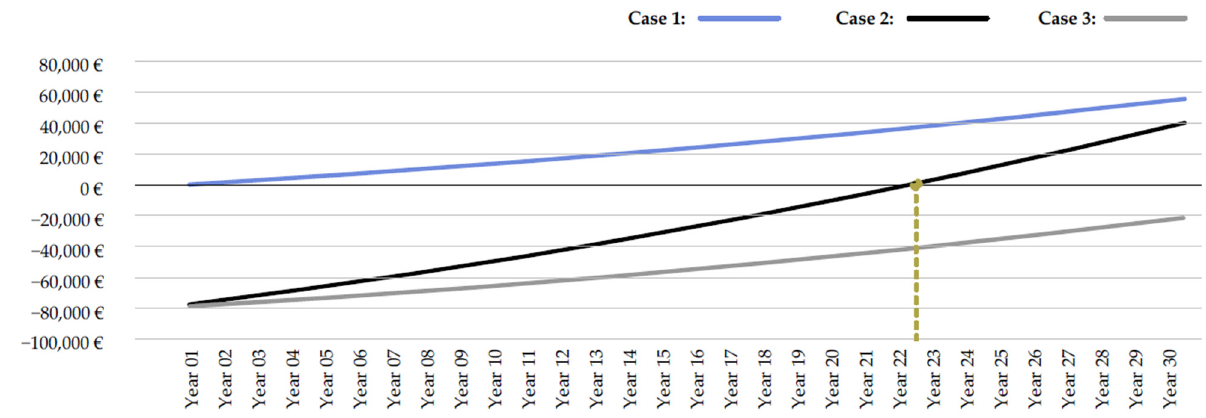
Figure 22. Calculation of the optimal cost of thermochromic paint for the case of Madrid.